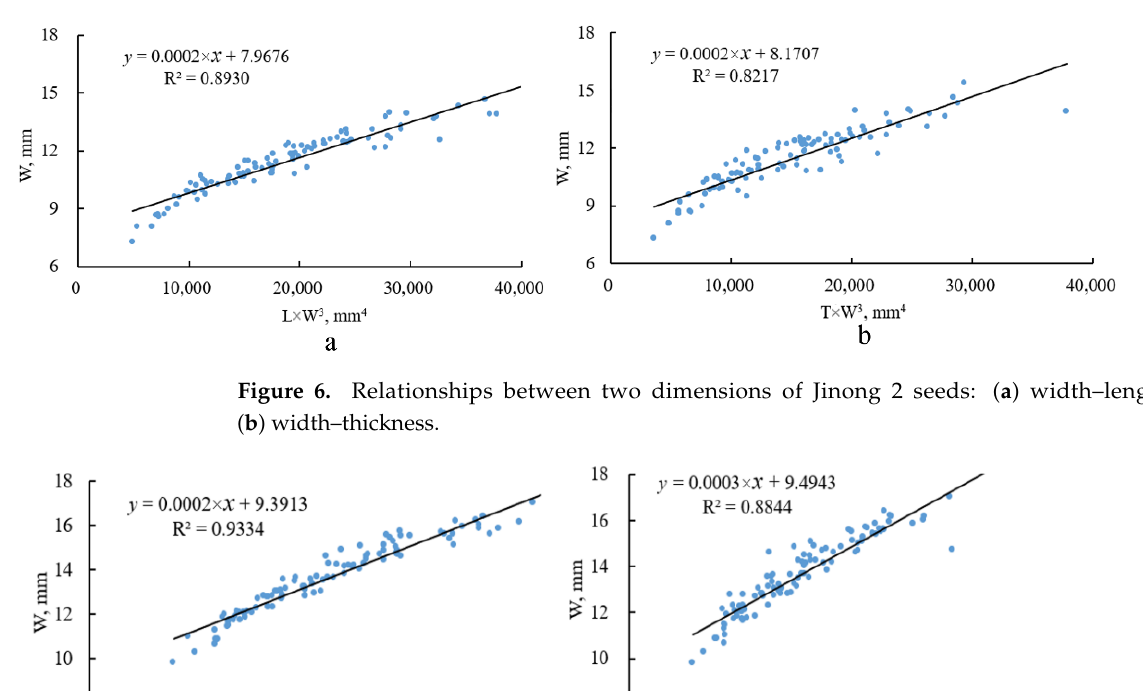
Figure 5. Relationships between two dimensions of Jinong 1 seeds: ( a ) width–length and ( b ) width– thickness.